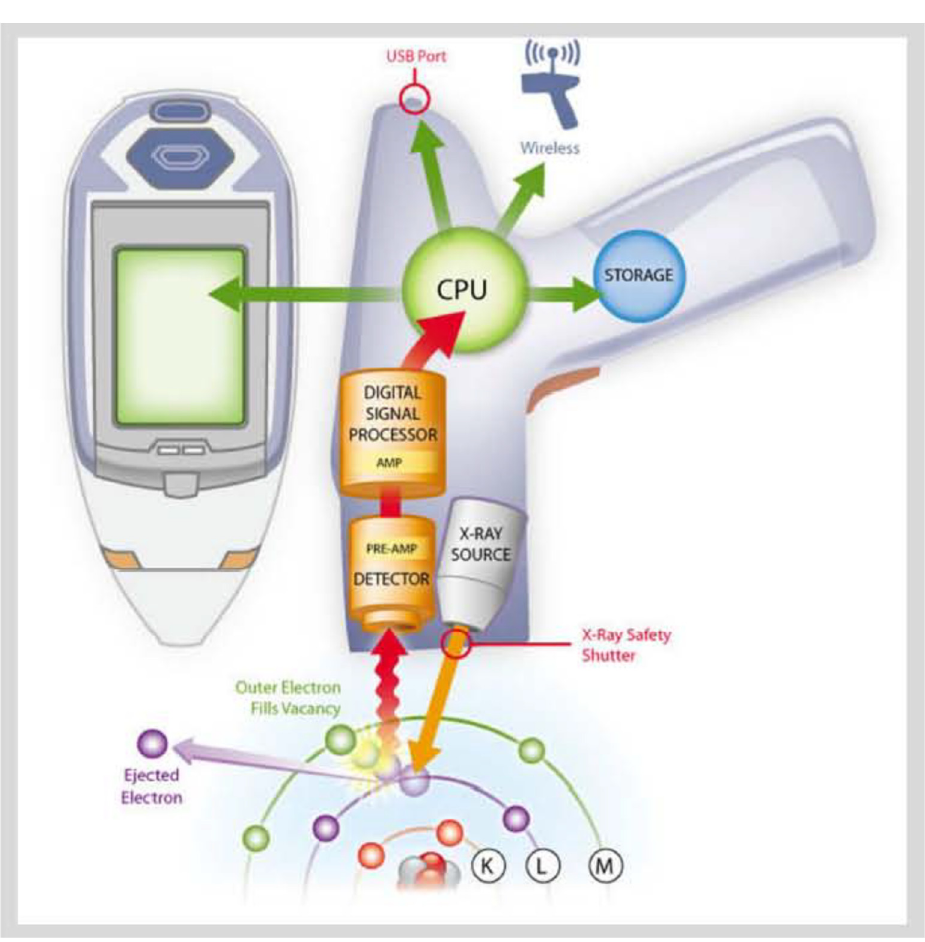
Figure 1. Functional schematic of a portable pXRF instrument (with permission of ThermoFisher, Waltham, MA, USA).